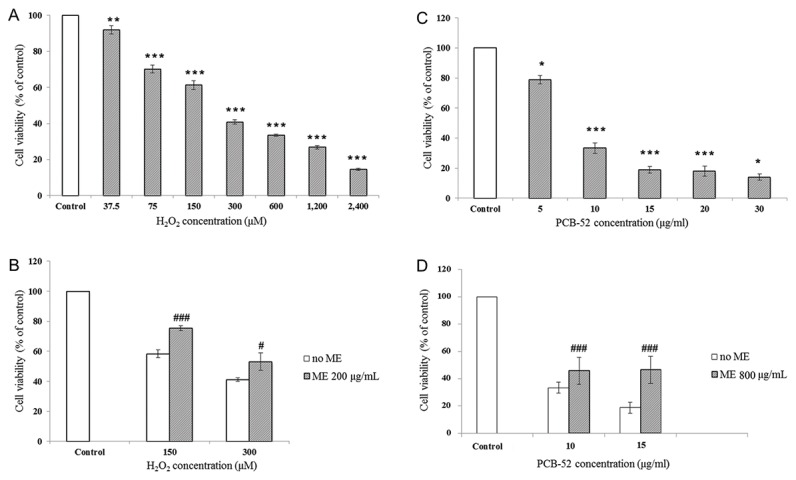
Effects of ME on chemical-induced cytotoxicity.(A) Cytotoxic effects of H2O2 on SK-N-SH cells after 24-h incubation. (B) Effects of ME on H2O2-induced cytotoxicity. (C) Cytotoxic effects of PCB-52 on SK-N-SH cells after 24-h incubation. (D) Effects of ME on PCB-52-induced cytotoxicity. SK-N-SH cells were preincubated with ME for 3 h before the treatment of H2O2 and PCB-52 for 24 h. Cell viability was determined by MTT assay and expressed as percentage compared to untreated cells. Data were reported as mean ± SEM (n=10 independent experiments for H2O2). *P < 0.05, ** P < 0.01, *** P < 0.001 compared to untreated control; #
P < 0.05, ###
P < 0.001 compared to cells treated with corresponding chemicals concentration with no ME preincubation.